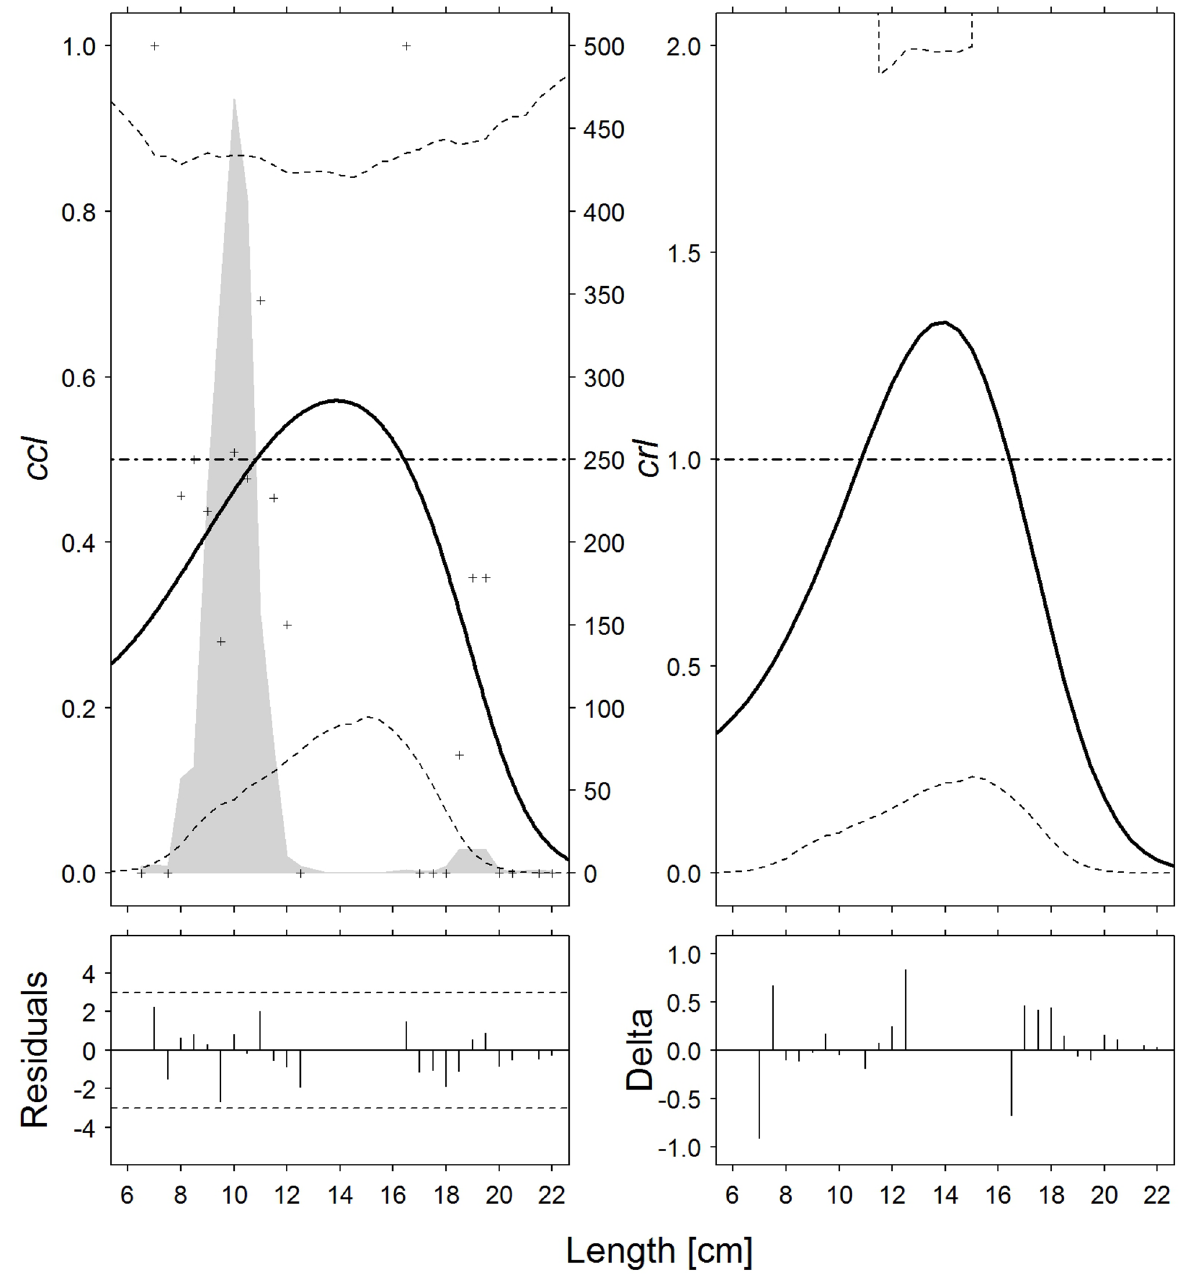
Fig 4. Atlantic horse mackerel ( T . trachurus ). Catch comparison rates ( cc 60-minute tows (solid curves). Crosses: experimental rates; thin dotted curves: 95% confidence intervals; grey solid curve: summed and raised catch populations for all hauls; horizontal dashed line: baseline of no effect on catch performance after changing tow duration. Partial residual plots ( bottom left ) and delta dispersion ( bottom right ) for the two models.